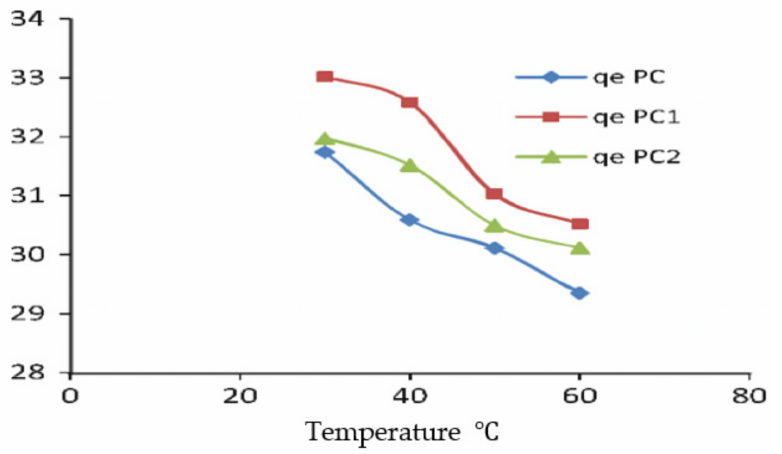
Figure 9. Biosorption when cone powder was used. PC: pinecone, PC1: modified pinecone with 0.1 M, PC2: modified pinecone with 0.05 M NaOH